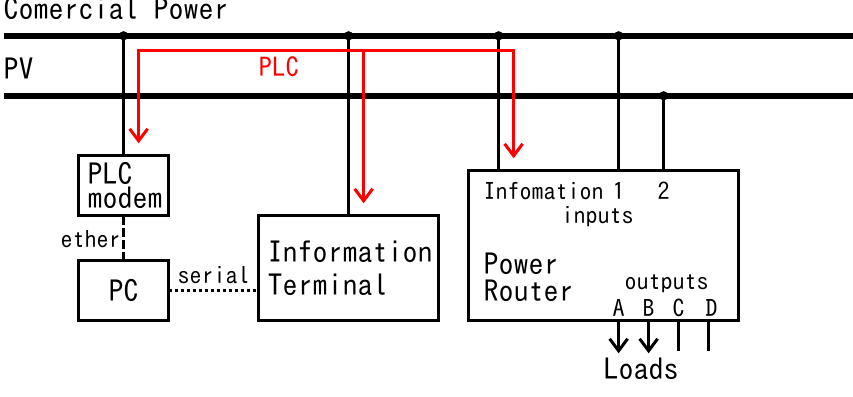
Figure 4. Schematic diagram of configuration of experiment.